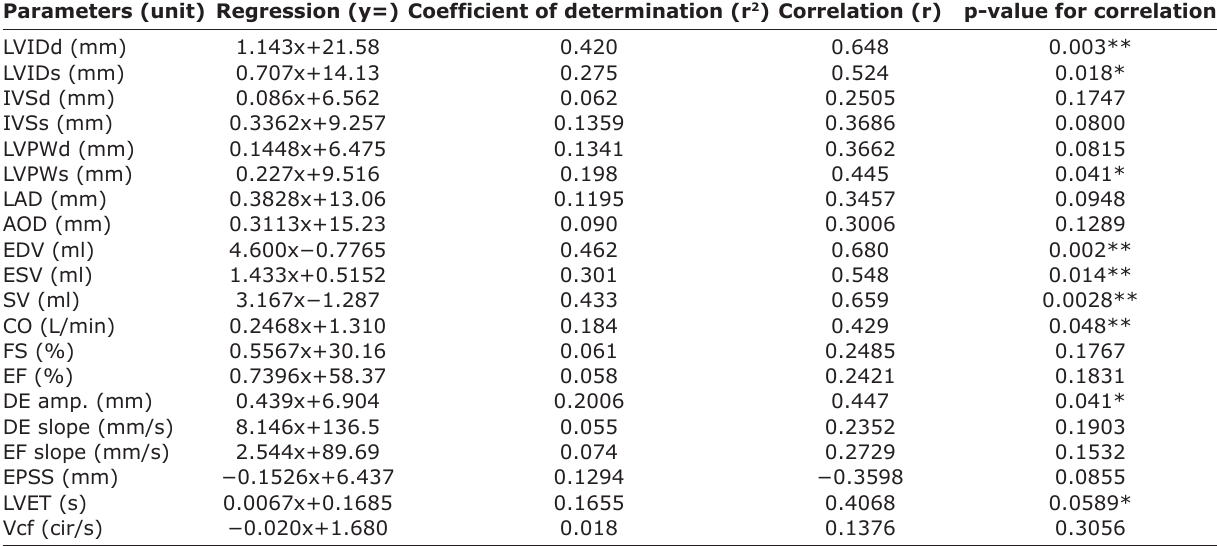
Table-4: Body weight correlation with echocardiographic measurements in Indian Spitz dogs. Parameters (unit) Regression (y=) Coefficient of determination (r 2 ) Correlation (r) p-value for